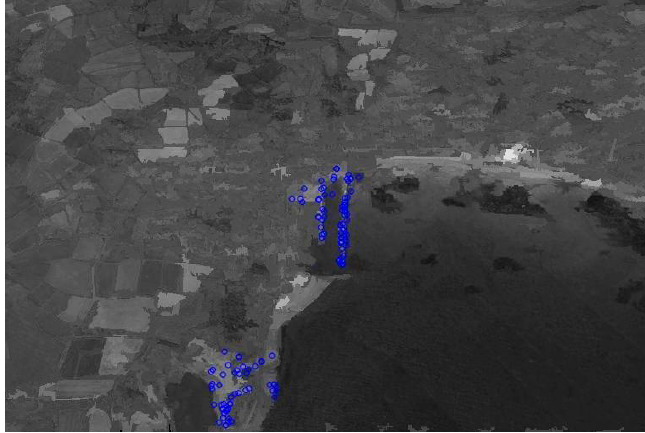
Figure 6. Improved harbor candidate region extraction result.